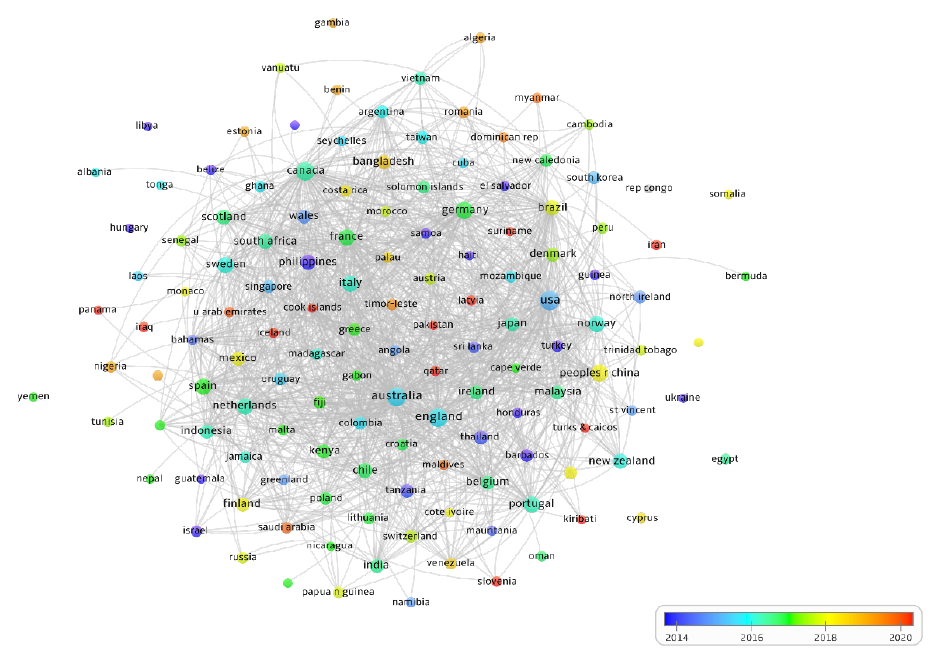
Figure 4. Temporal national co-authorship network.